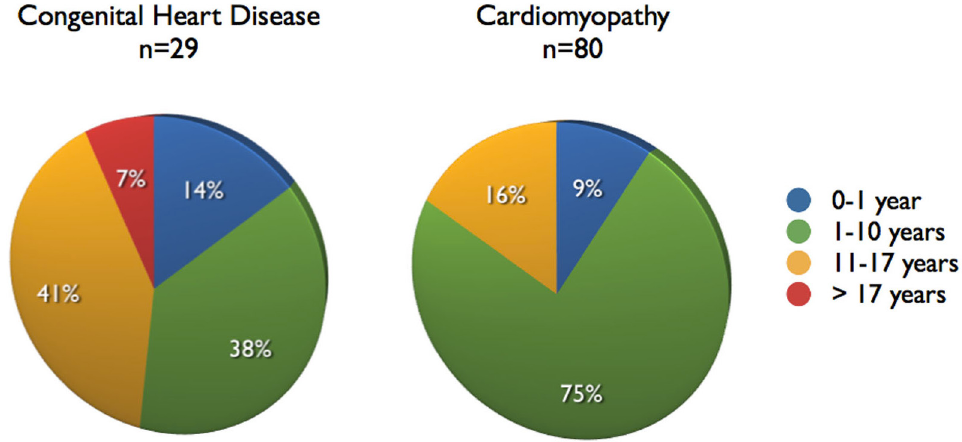
Fig. 1 - Age distribution between congenital heart disease and cardiomyopathy.